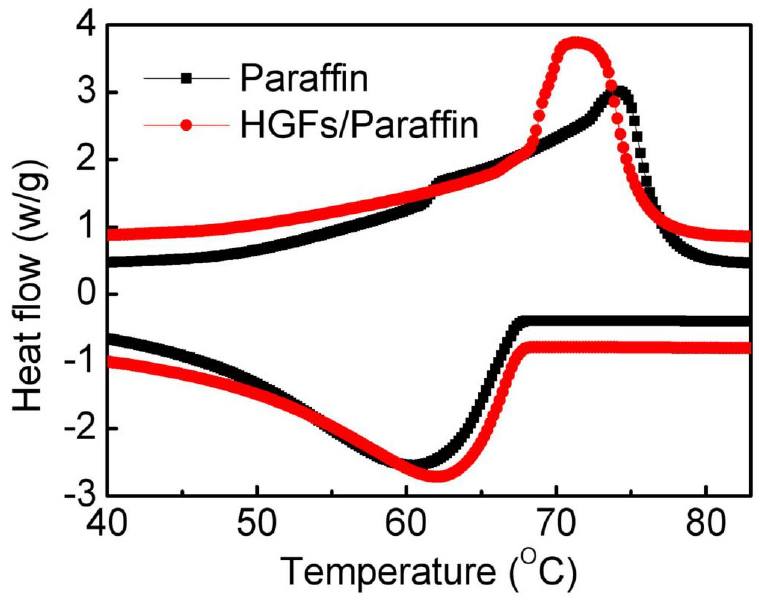
Figure 6. The DSC curves of the paraffin and HGFs/paraffin composite.